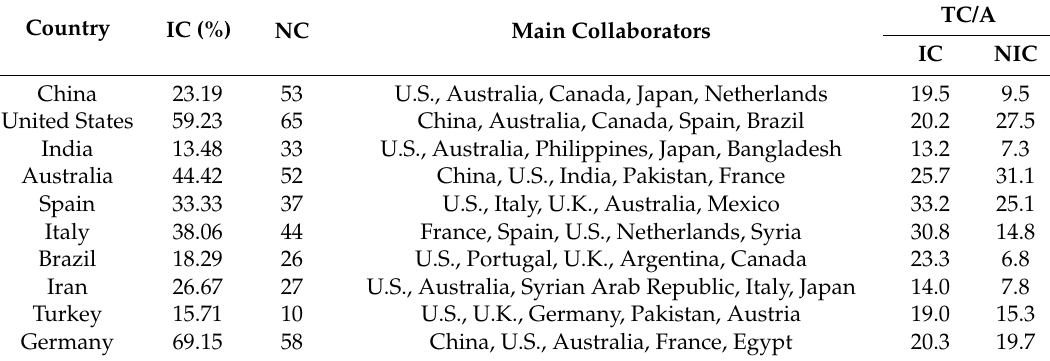
Table 4. International collaboration for the most productive countries in WUEA research from 1988–2017.